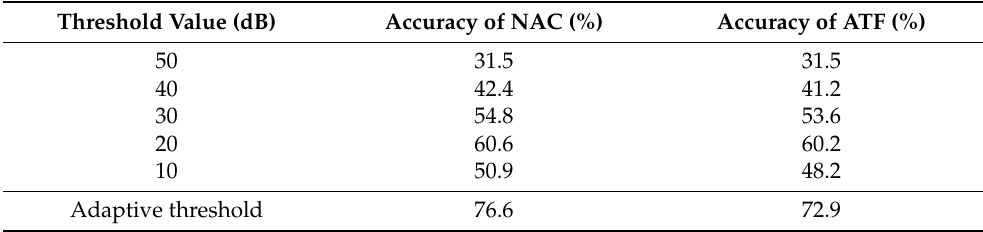
Table 7. The ASP measurement performance comparison of the two threshold-based